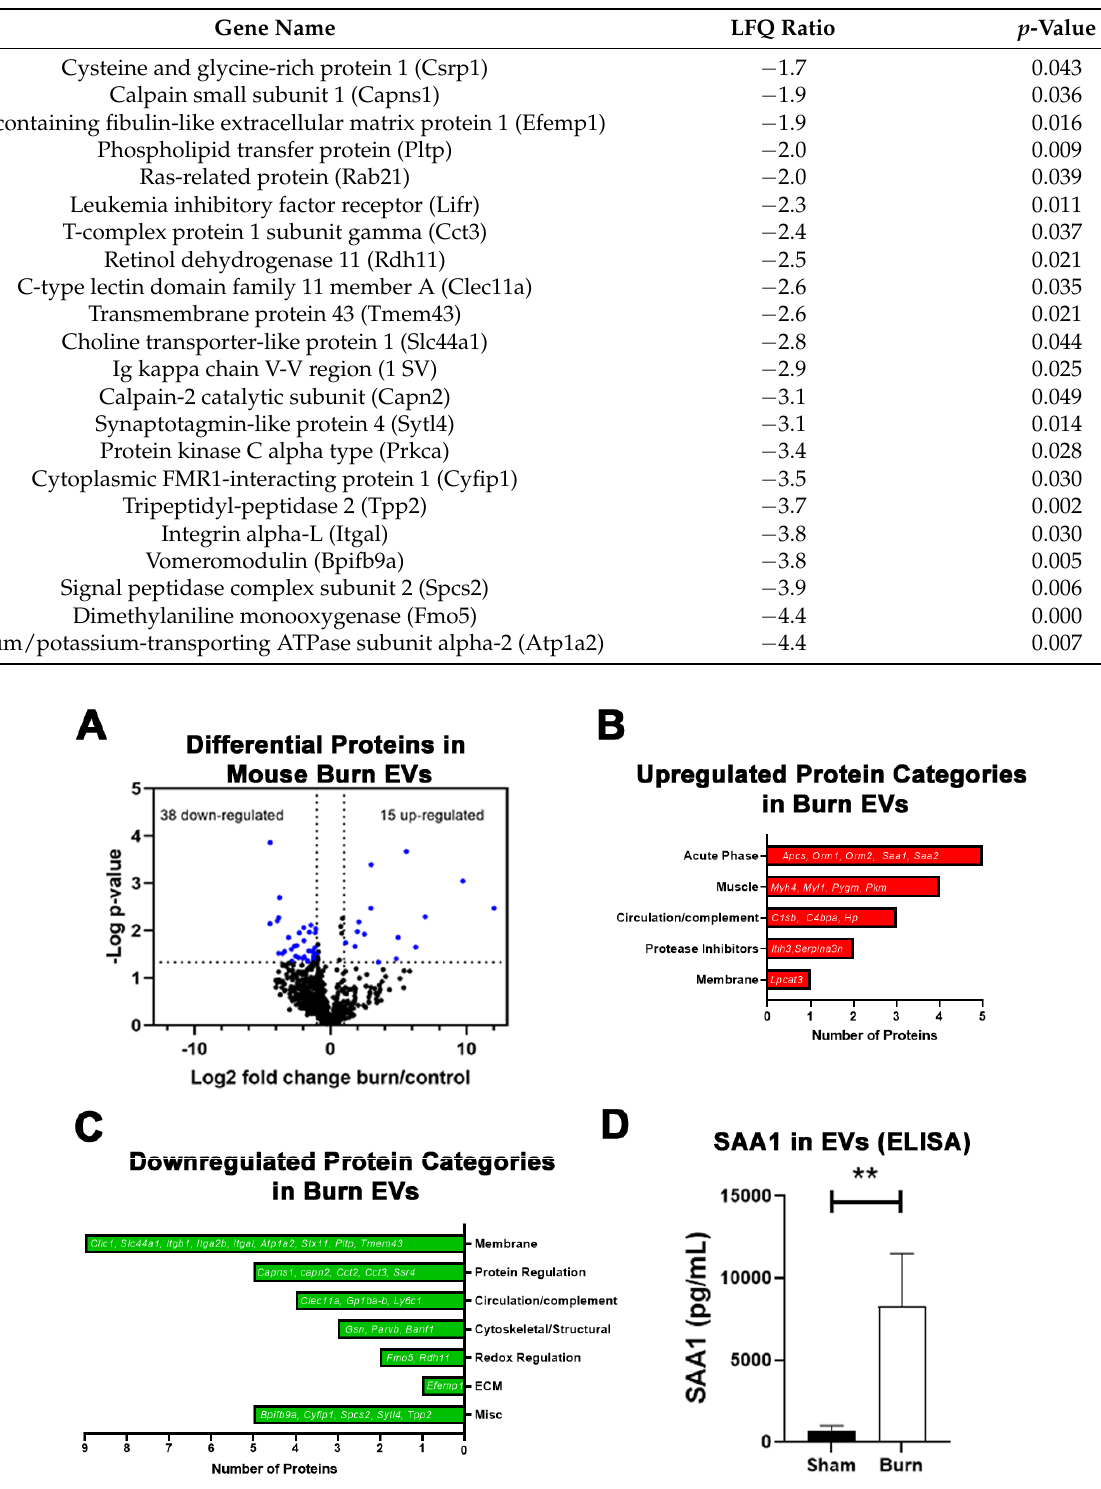
Figure 3. Proteomic changes in mouse plasma EVs after burn injury. Adult mice underwent a 20% total body surface area (TBSA) burn injury and plasma EVs were collected 72 h after injury and protein content measured by LC-MS/MS. ( A ) Differentially expressed protein peptides in burn vs. sham EVs (LFQ ratio, p -value Student’s t -test, n = 3 per group). ( B ) Characteristics of proteins that are increased in burn EVs relative to controls. ( C ) Characteristics of proteins that are decreased in burn EVs relative to controls. ( D ) ELISA measurement of SAA1 in plasma EVs from sham and burn mice. SAA1 protein was robustly increased in burn-EVs compared to sham. ** p < 0.01, t -test, n = 4 sham, 8 burn.